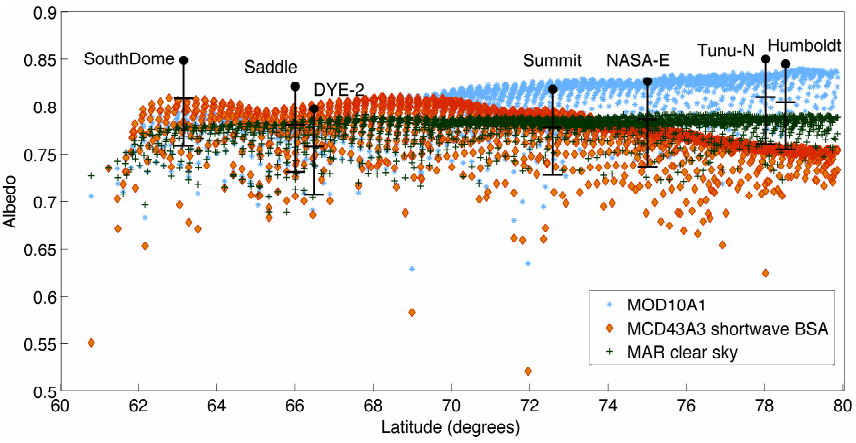
Figure 5. 2000–2012 mean JJA albedo (unitless) for the MAR accumulation zone vs. latitude, for MOD10A1, MCD43A3 BSA SW, MAR v3.2 clear-sky, and GC-Net station data (black circles) for stations with a record spanning at least seven years of the 2000–2012 period. Only MODIS data flagged as “good quality” were used here. The error bars for GC-Net stations indicate the range of corrections to GC-Net data (between 0.04 and 0.09) employed by Stroeve et al.